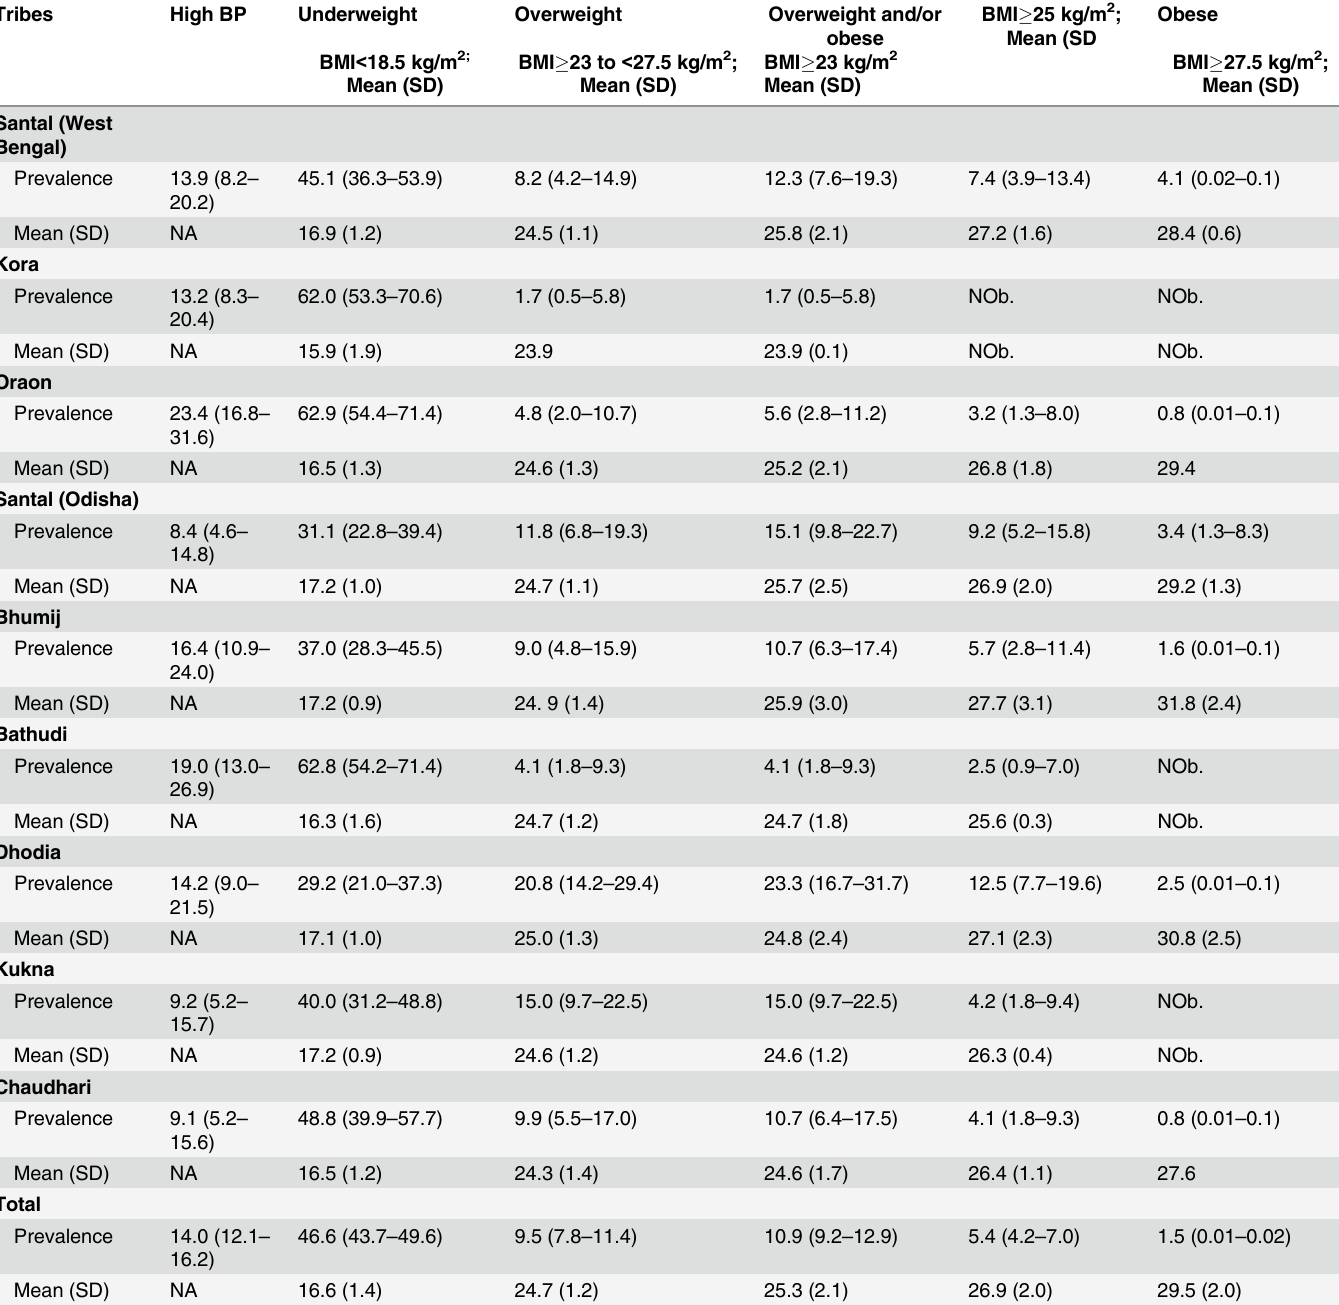
Table 4. Prevalence (%) of high blood pressure, underweight (BMI < 18.5 kg/m 2 ), overweight and/or obese (BMI (cid:1) 23 kg/m 2 ), and obese (BMI (cid:1) 27.5 kg/m 2 ) among the women (95% CI) with mean and standard deviation. Tribes High BP Underweight Overweight Overweight and/or